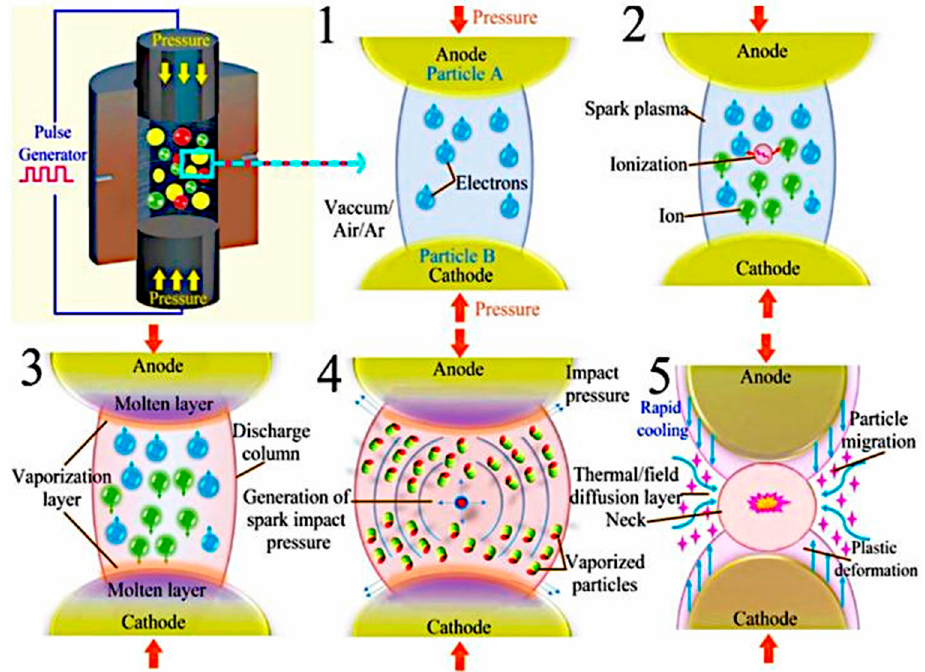
Figure 9. Neck formation mechanism in SPS Process